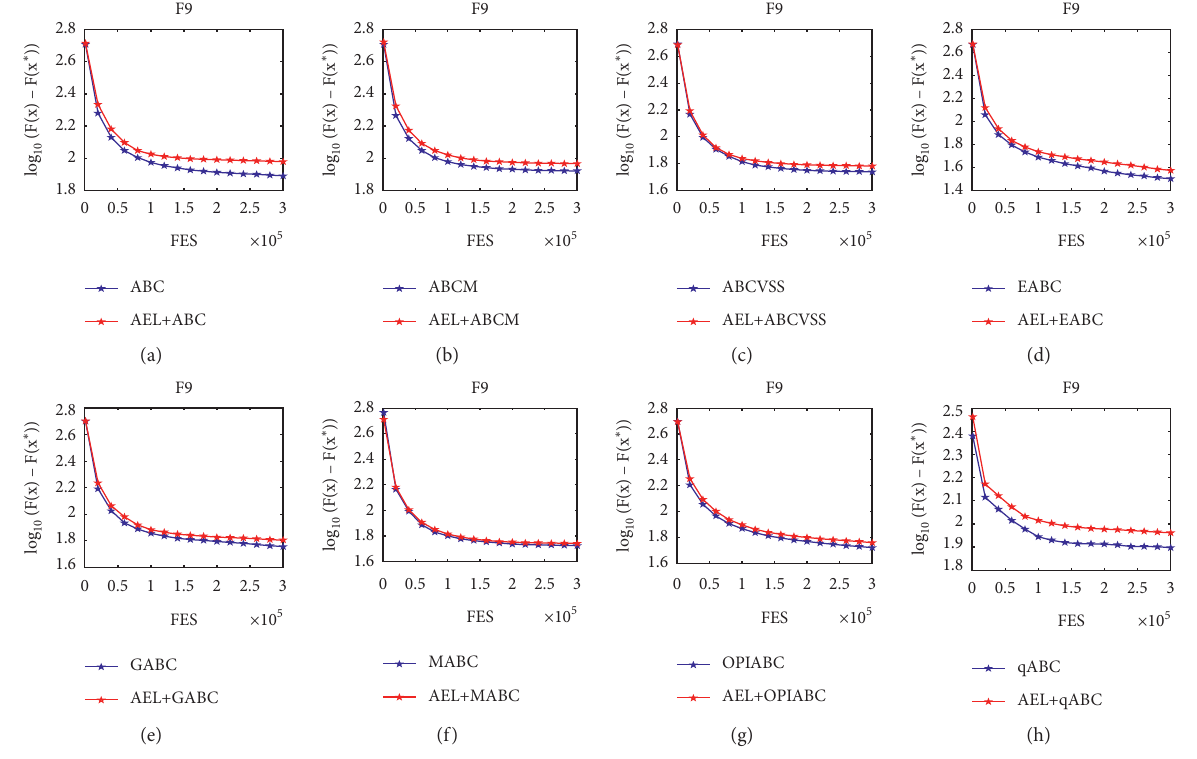
Figure 1: The convergence curves of AEL+ABCs vs. ABCs on F9 with 30 D